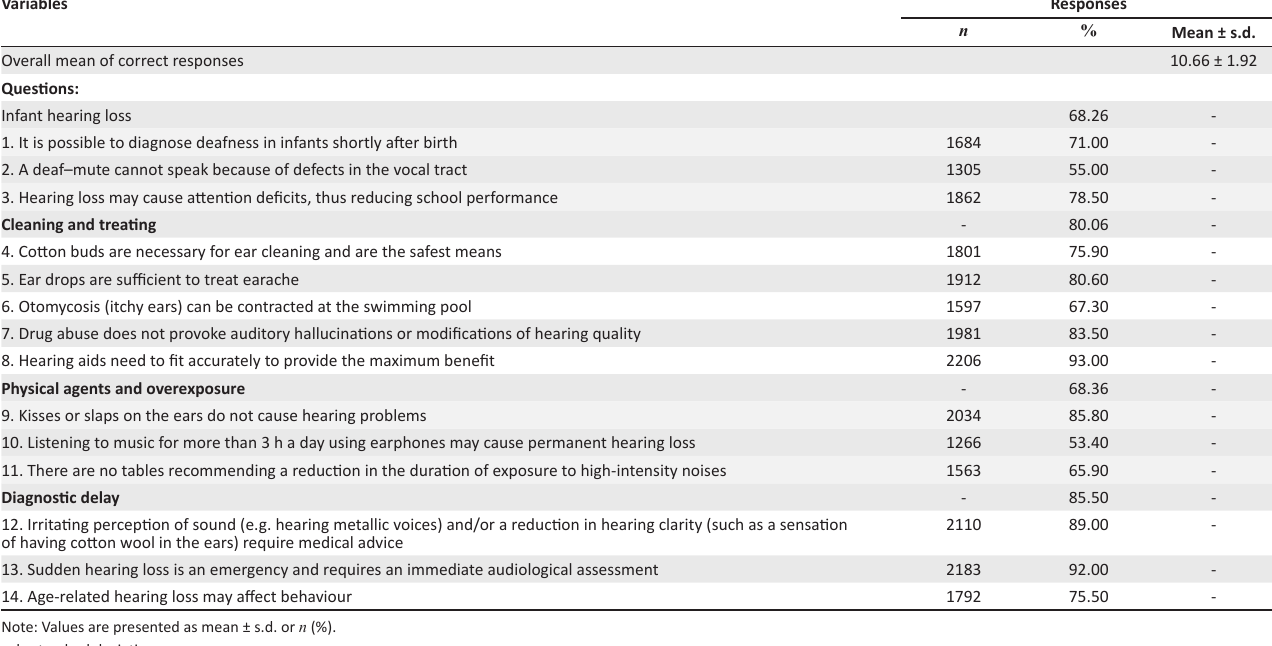
TABLE 3: The percentage of correct responses to the true or false questionnaire among the sample ( n = 2372). Variables